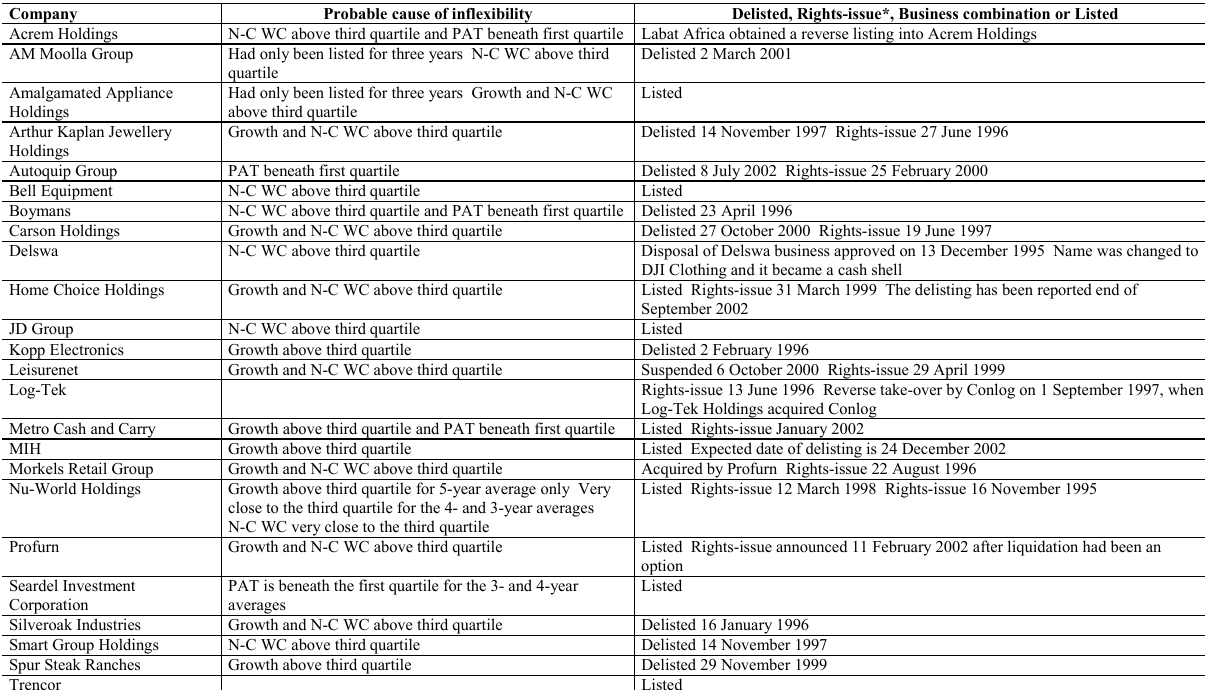
Table 6: Analysis per company